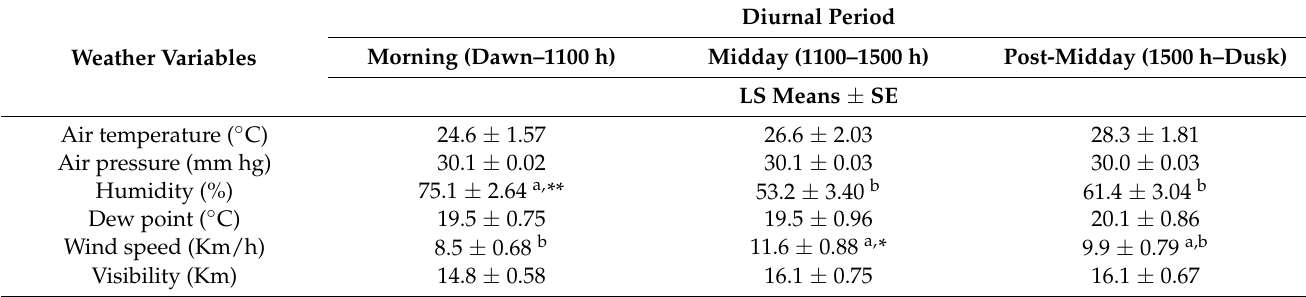
Table 1. Weather parameters for different diurnal periods of behavior observation days at the study site, June–August 2018.